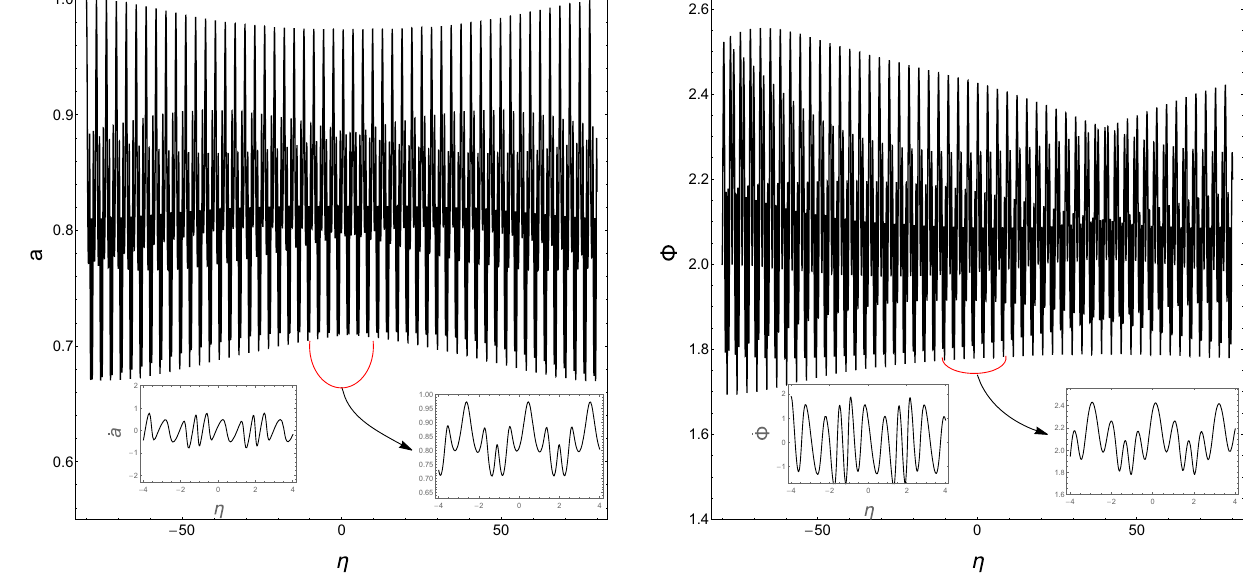
Fig. 8 Dynamical evolution of scale factor (left panel) and the BD scalar field (right panel) for γ = 4 / 3, ω = − 2 . 6 and r = − 5. The initial values for dynamical variables has been set as X 0 = Y 0 = 0,